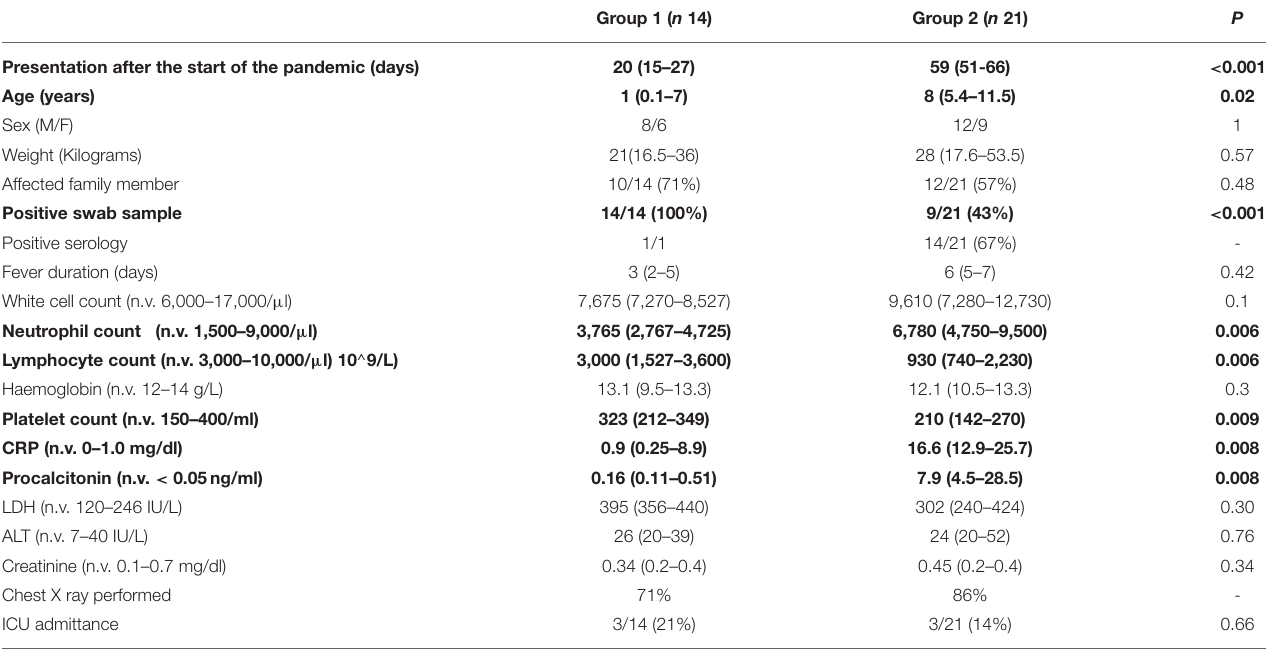
TABLE 2 | Comparison between the two groups of patients diagnosed with SARS-CoV-2 infection cases. Group 1 ( n 14) Group 2 ( n 21) P Presentation after the start of the pandemic